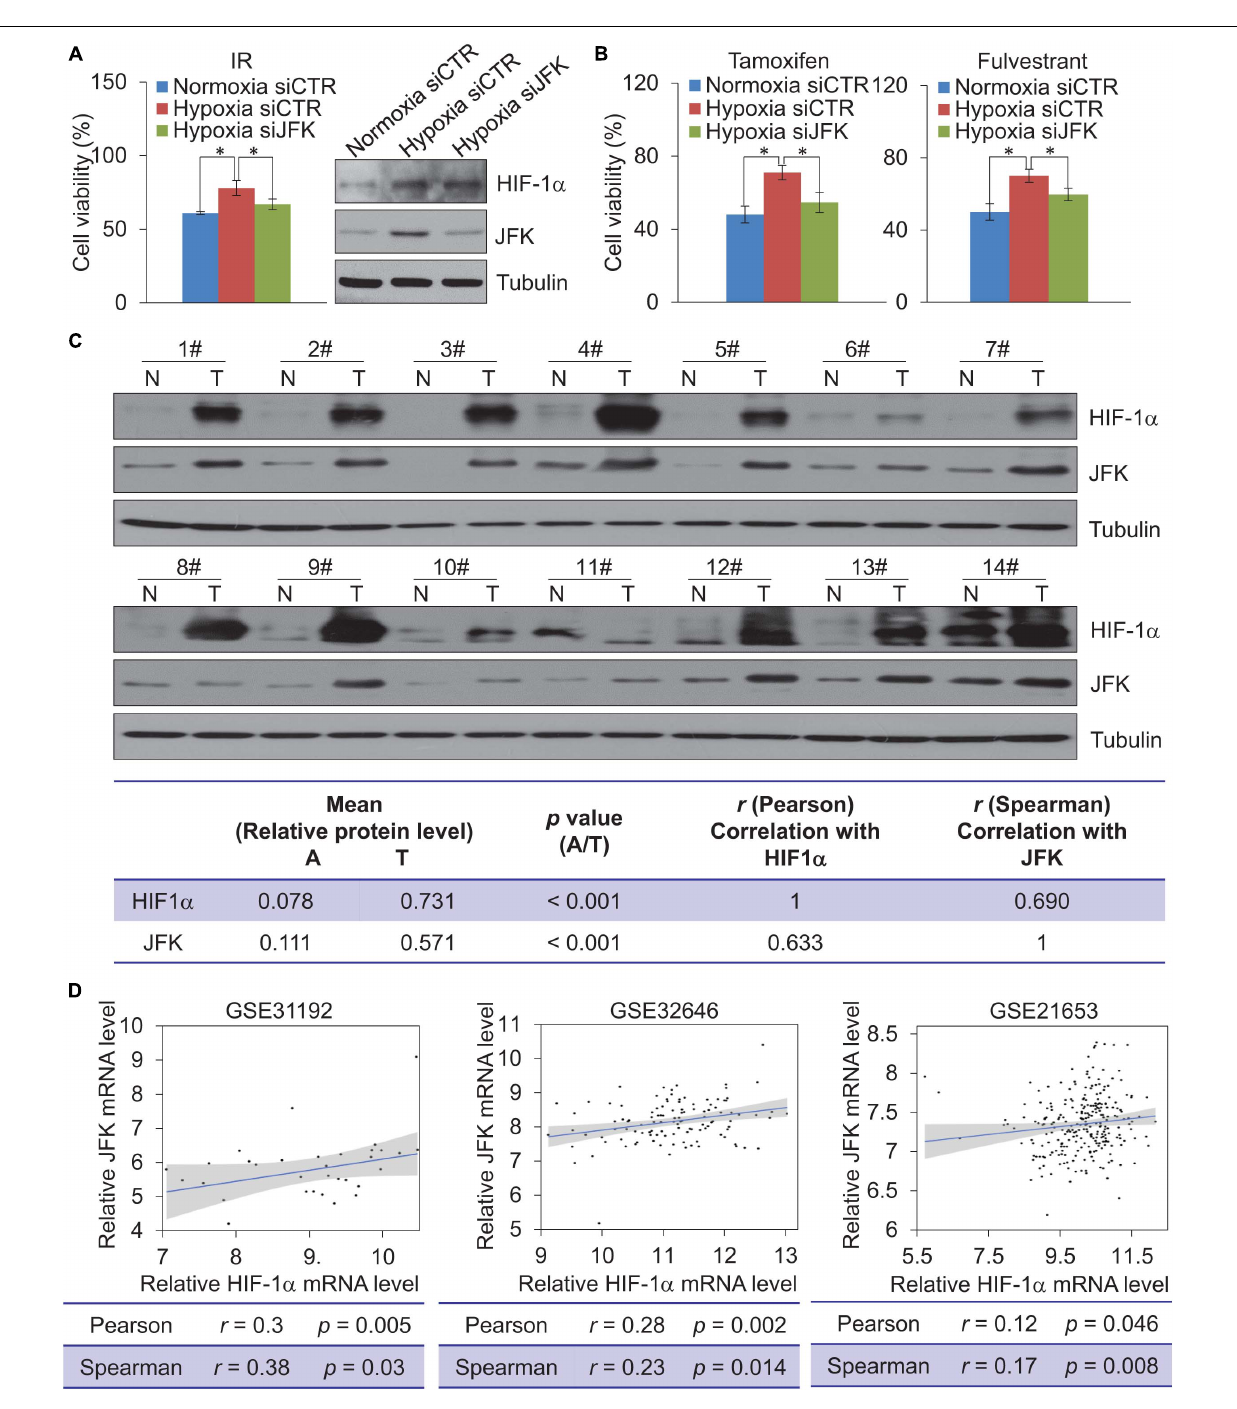
Frontiers in Cell and Developmental Biology |